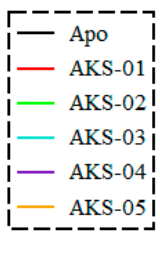
Figure 5. Root Mean Square Deviation of backbone carbon atoms of Apo (Omicron’s RBD) and five selected compounds in complex with RBD over the 100 ns of simulation time.